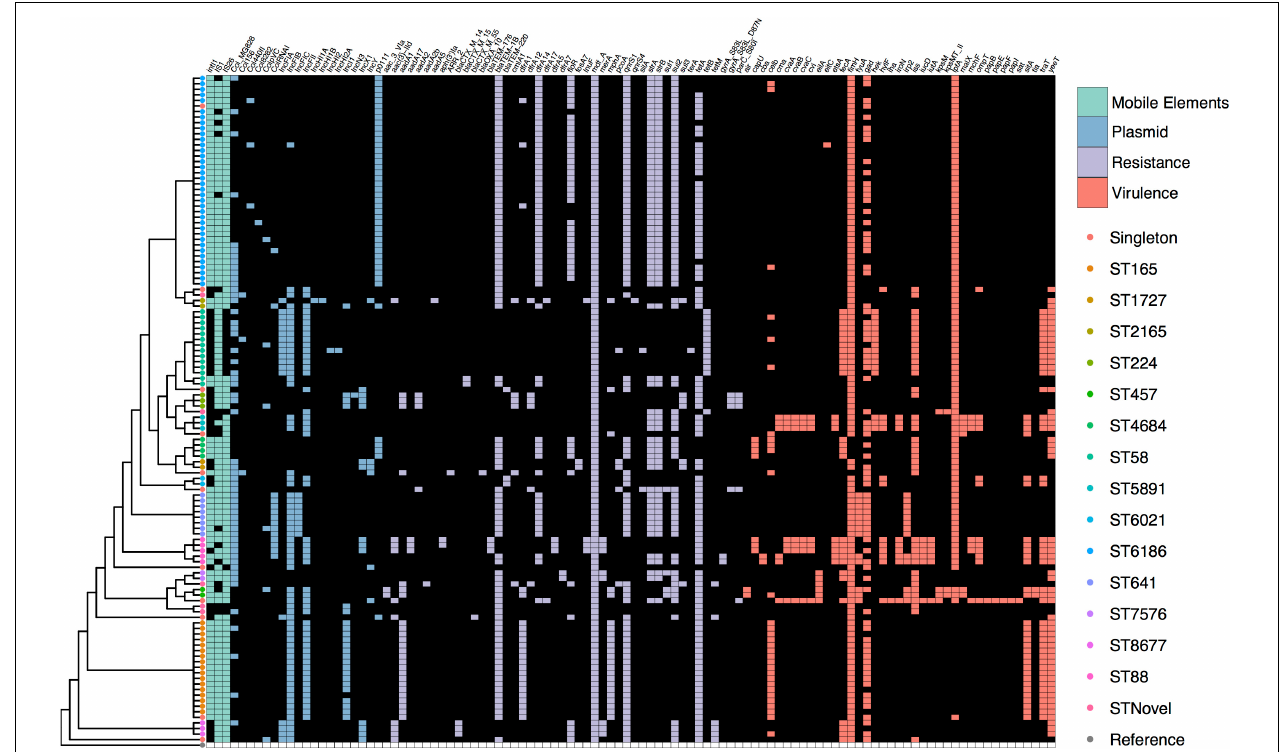
FIGURE 2 | SNP cladogram from Figure 1 mapped against gene presence and absence including fluoroquinolone resistance SNPs. Colored tree nodes indicate strain ST. Colored squares indicate presence of genes: green - mobile elements; blue - plasmid replicons; purple - resistance genes; red - virulence-associated